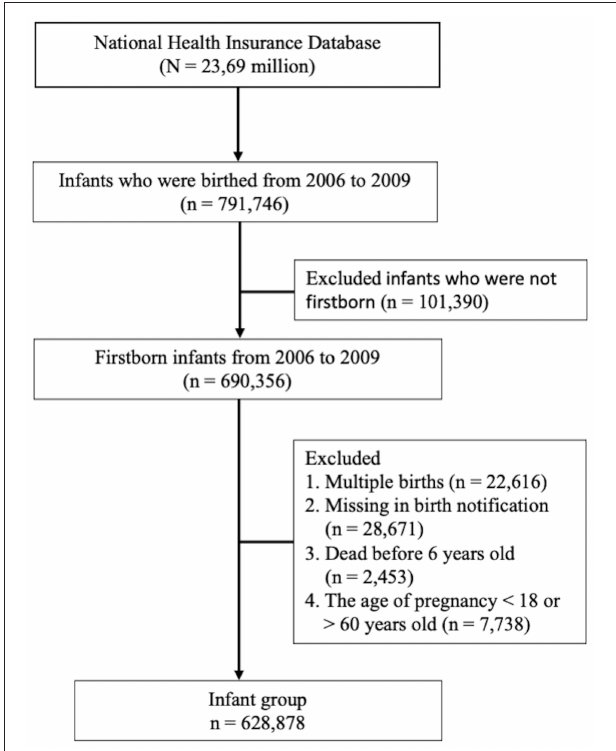
FIGURE 1 | Flowchart of the study subject